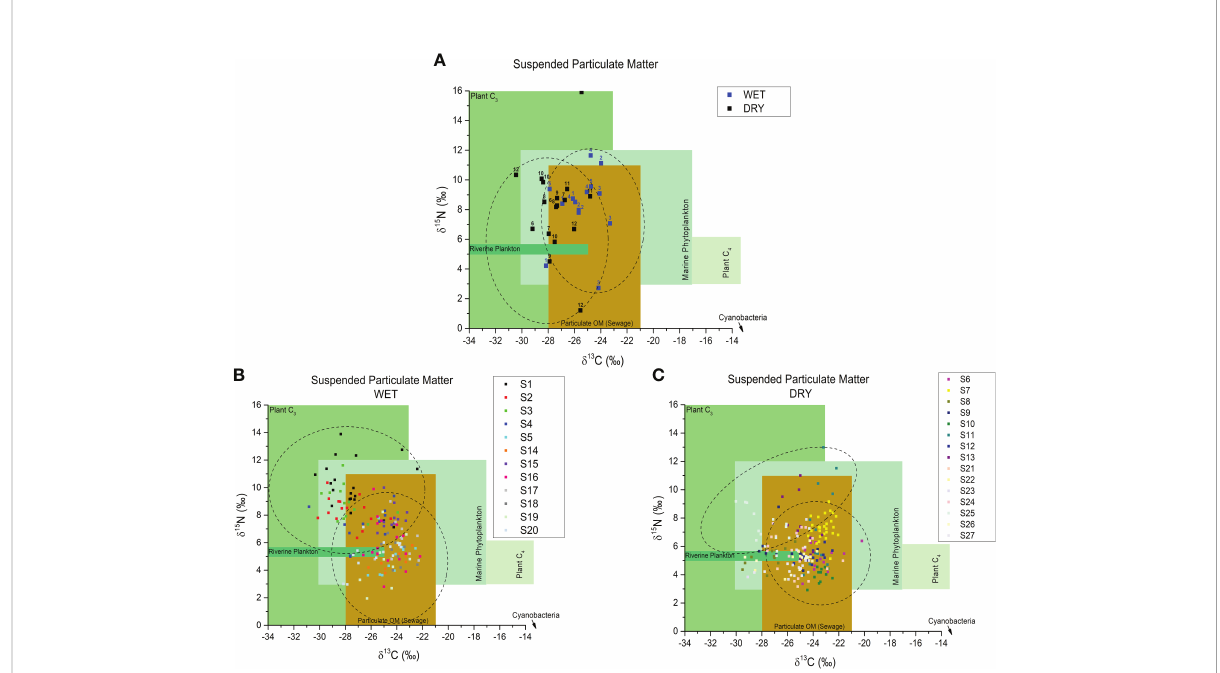
FIGURE 2 Distribution of isotopic composition of suspended particulate matter (SPM) relative to d 13 C and d 15 N and organic matter sources according to Maksymowska et al. (2000) classi fi cation in the river channel (A) and on the continental shelf (B, C) in both dry and wet